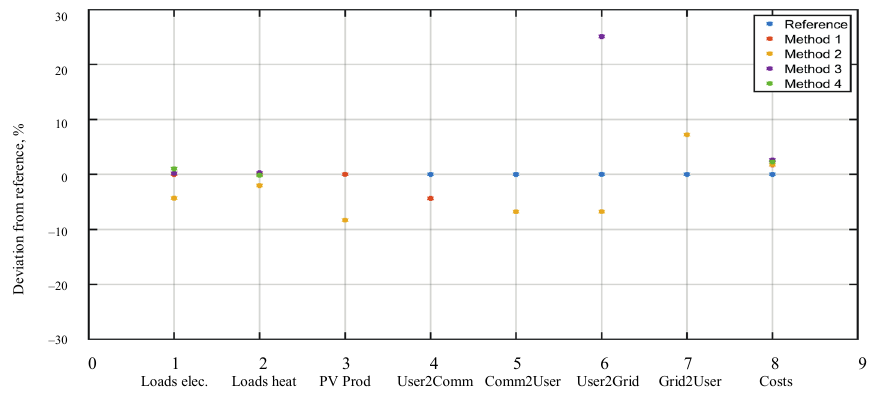
Fig. 4. Summary of the results of scenario